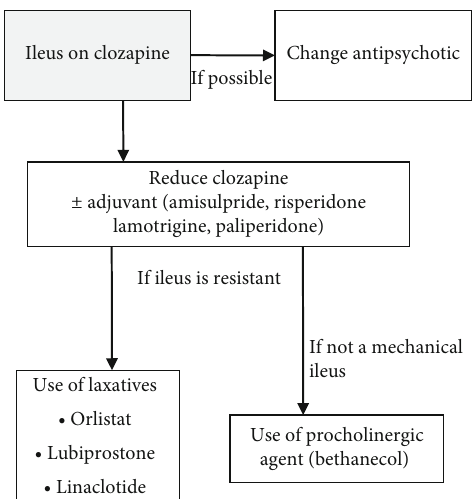
Figure 1: Treatment algorithm for the management of an ileus on